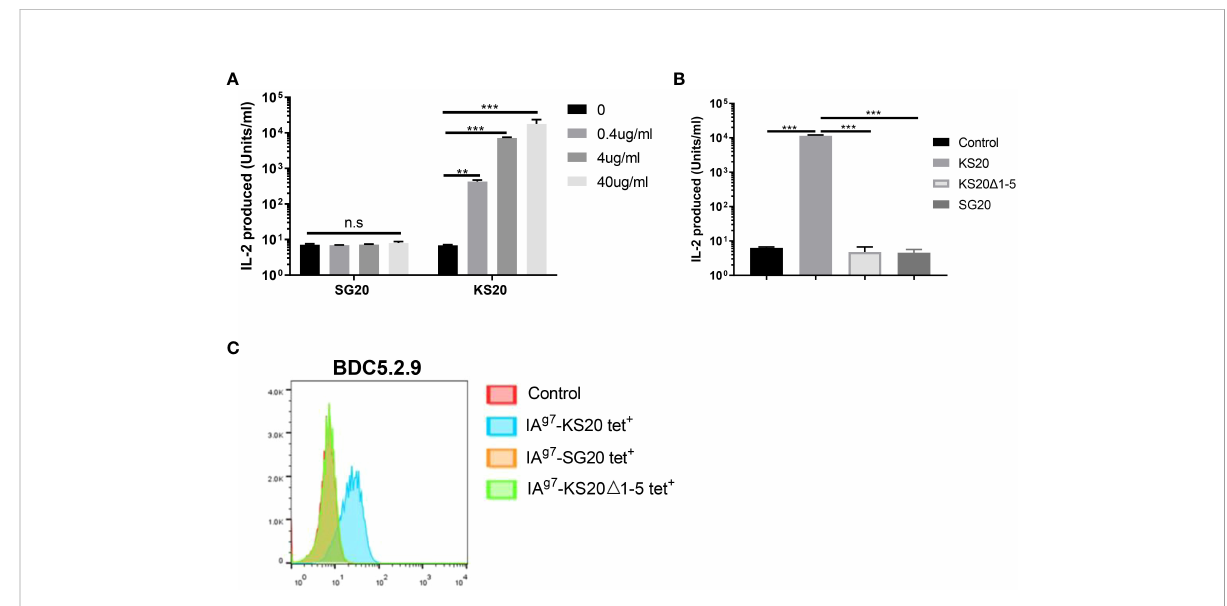
FIGURE 2 The cross-reaction between the CGRP peptide and IAPP reactive T cell, BDC5.2.9. (A) M12C3G7 incubated with SG20 or KS20 peptides stimulated BDC5.2.9 at different concentrations, 0, 0.4, 4 and 40 m g/mL. 24 hours later, supernatants were collected for HT-2 assay. Results are the means ± SEM of triplicate wells. (B) ICAM+B7 + SF9 insect cells expressing IA g7 -WT KS20, IA g7 -KS20 △ 1-5, or IA g7 -SG20 were used as APCs to stimulate BDC5.2.9 T cells. Results are the means ± SEM of triplicate wells. (C) IA g7 -SG20 tetramers were used to stain BDC5.2.9. IA g7 -KS20 was used as a positive control and IA g7 -KS20 △ 1-5, as a negative control. * P < 0.05, ** P < 0.01, *** P <